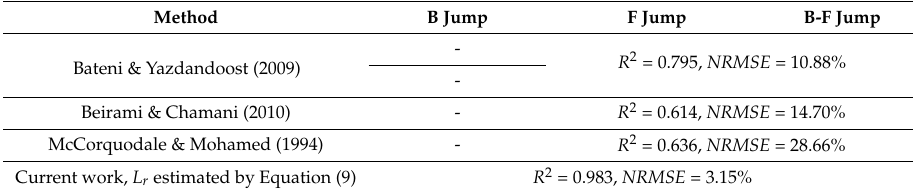
Table 2. Summary of results for different methods for estimation of roller length L r